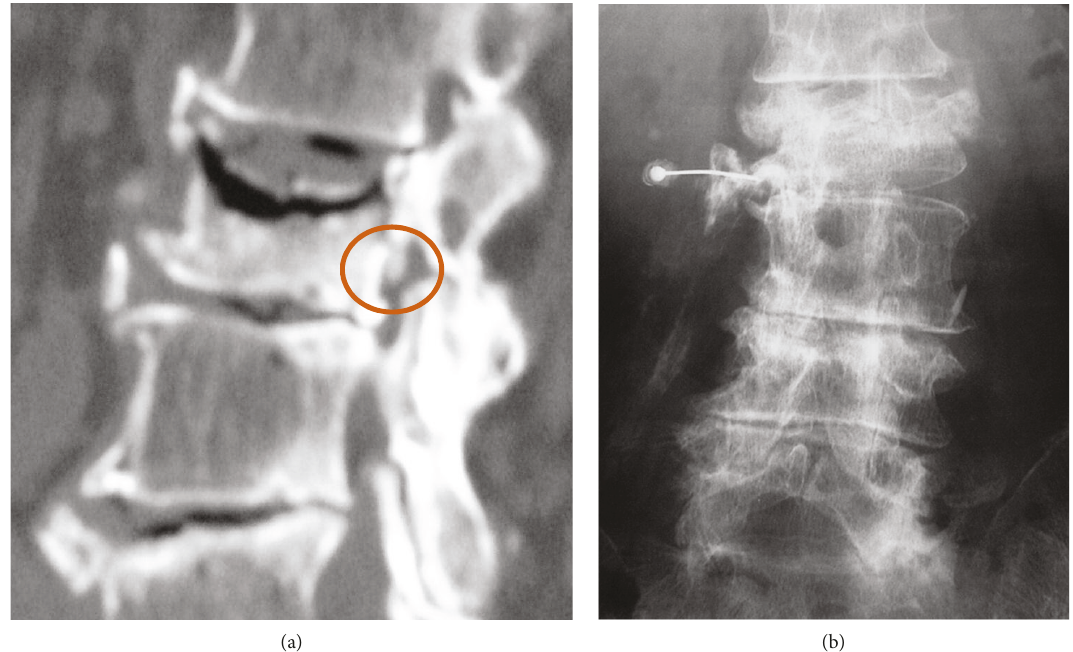
Figure 2: (a, b) Three-dimensional computed tomography image showing the bone tip under the right L2 pedicle. Left L2 root block was e ff ective temporally, and radiography showed that left L2 root compressed at intervertebral foramen.